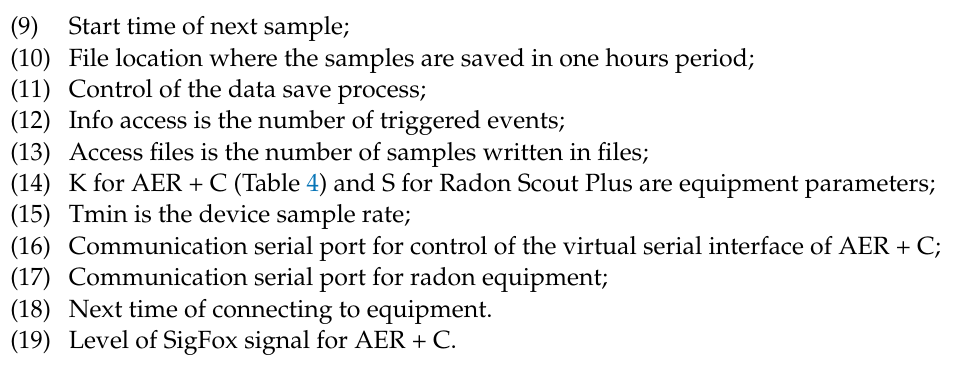
Table 4. Dependence of measurement accuracy, depending on the sampling rate, AER + C equipment. Sample